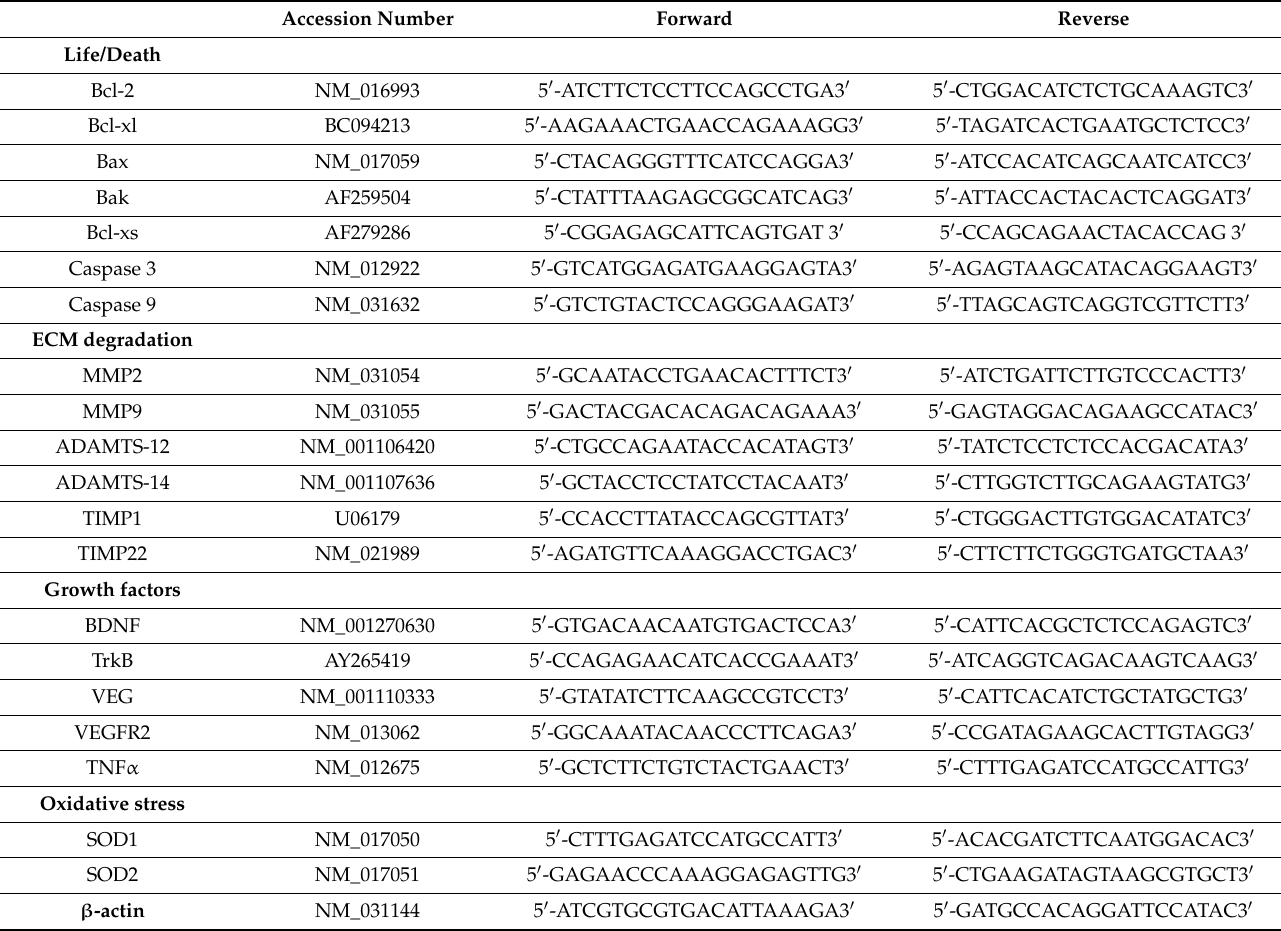
Table 1. Genes sequences analyzed in this